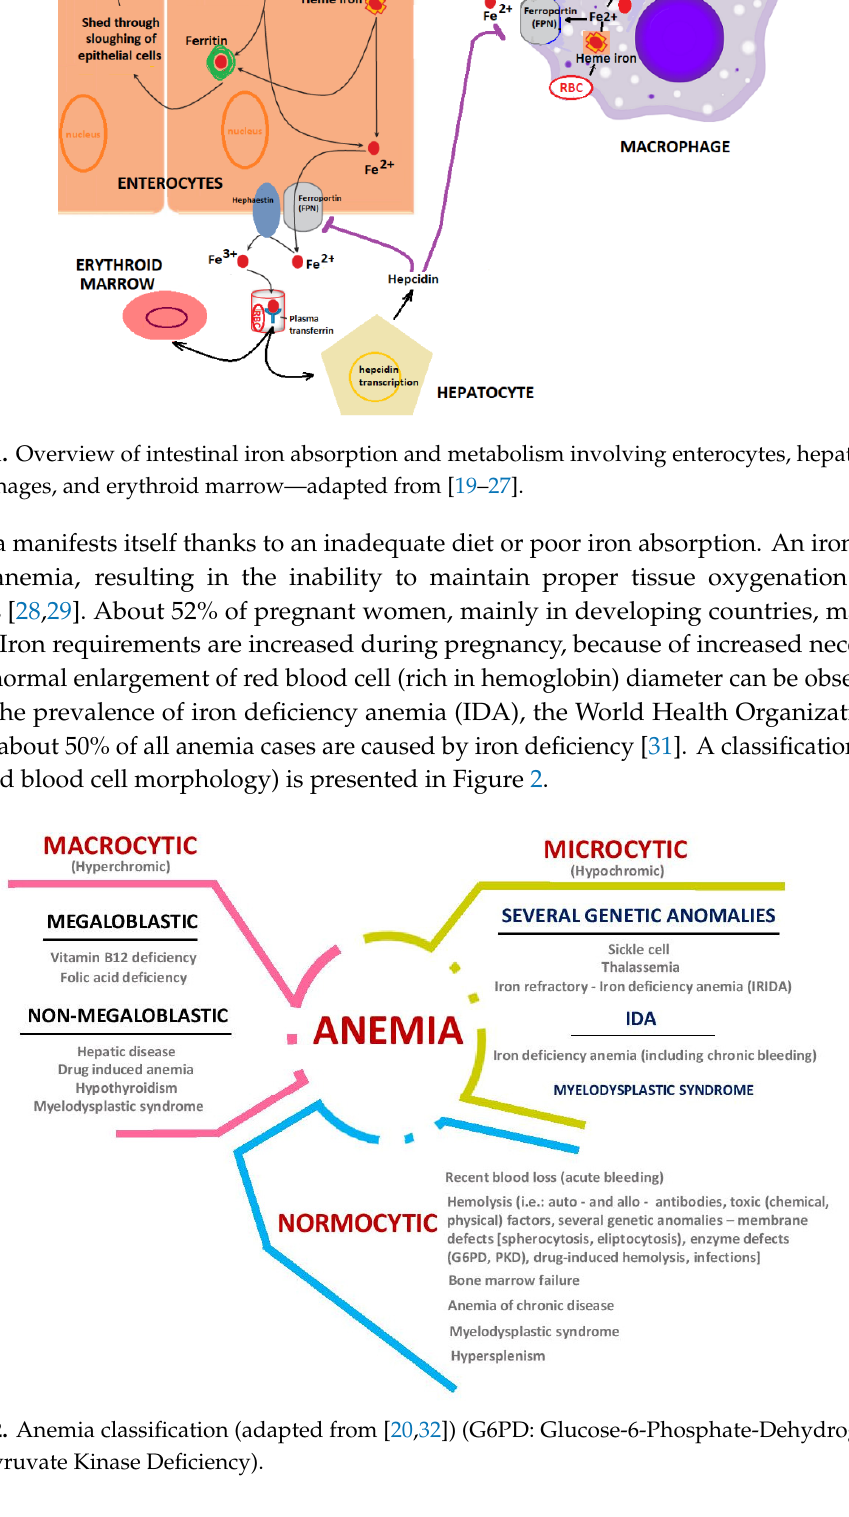
Figure 1. Overview of intestinal iron absorption and metabolism involving enterocytes, hepatocytes, macrophages, and erythroid marrow—adapted from [19–27].